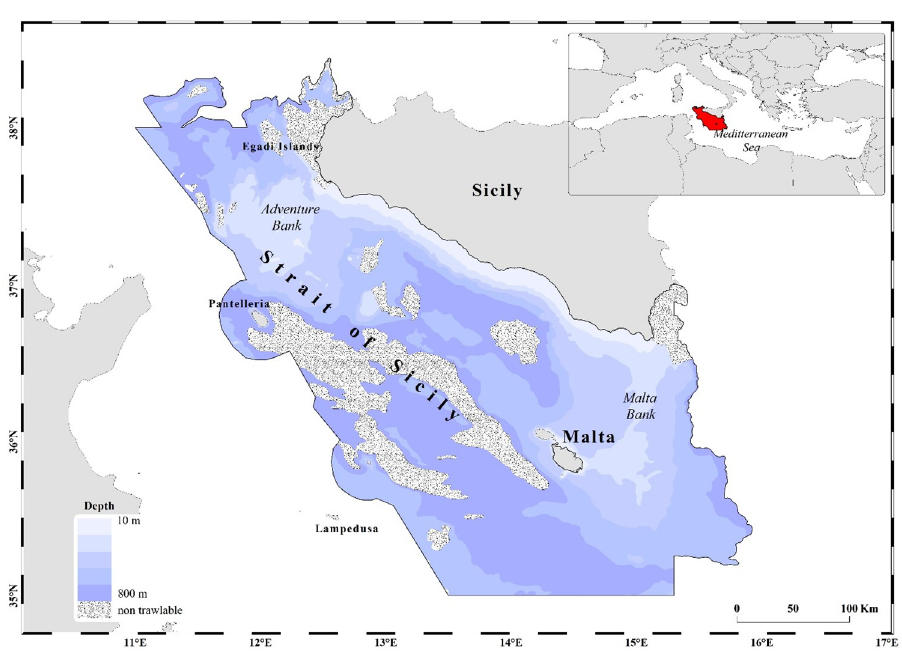
Fig 1. Area of the food web model (about 61,000 km 2 ) applied to the Strait of